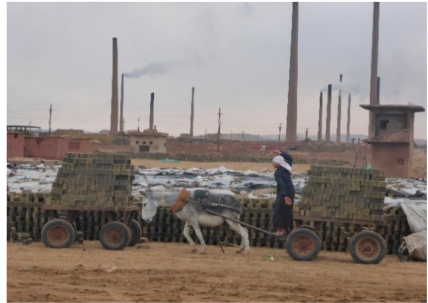
Figure 5. A cart loaded with brick cargo; the driver hits the donkey on its